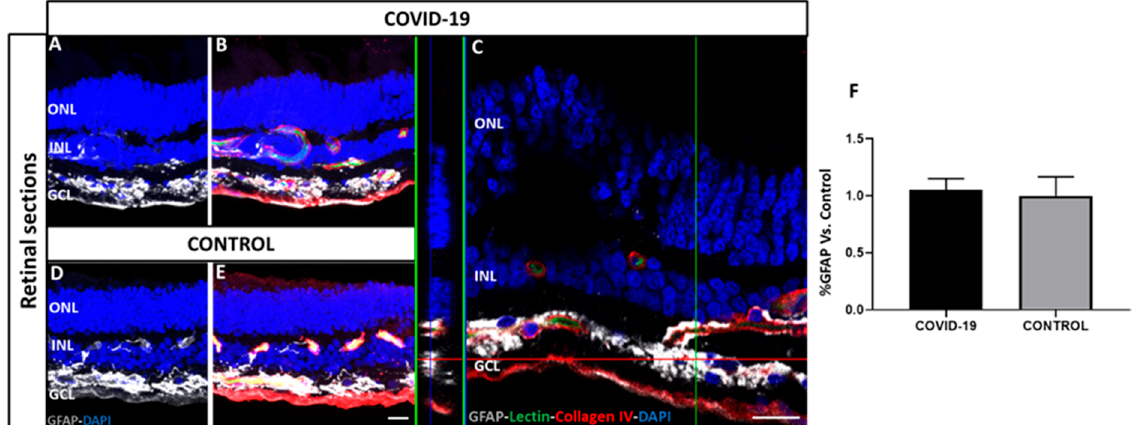
Figure 6. Localization and quantification of glial fibrillary acidic protein (GFAP) staining (white) in COVID-19 ( A – C ) and control retinal cross-sections ( D , E ) previously labelled with lectin (green) and collagen IV (red) antibodies. There were no differences between COVID-19 ( A – C ) and control retinas ( D , E ). Image C is a magnification of GFAP staining in GCL. DAPI (blue) labels nuclei. ( F ) Quantification of immunofluorescence intensity in percentage of COVID-19 retinas vs. controls shows no significant differences. Scale bar: 100 µm. Abbreviations: GCL (ganglion cell layer), INL (inner nuclear layer), ONL (outer nuclear layer).